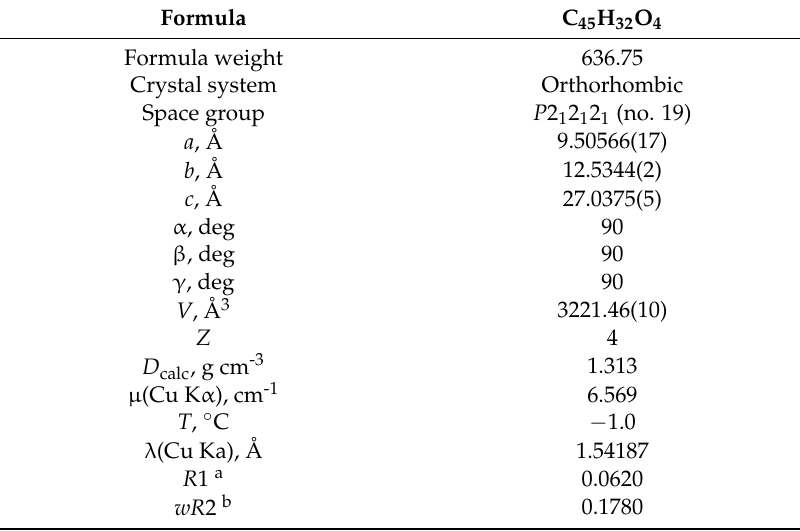
Table 1. X-ray crystallographic data for bispyrenyl malonate 1 .